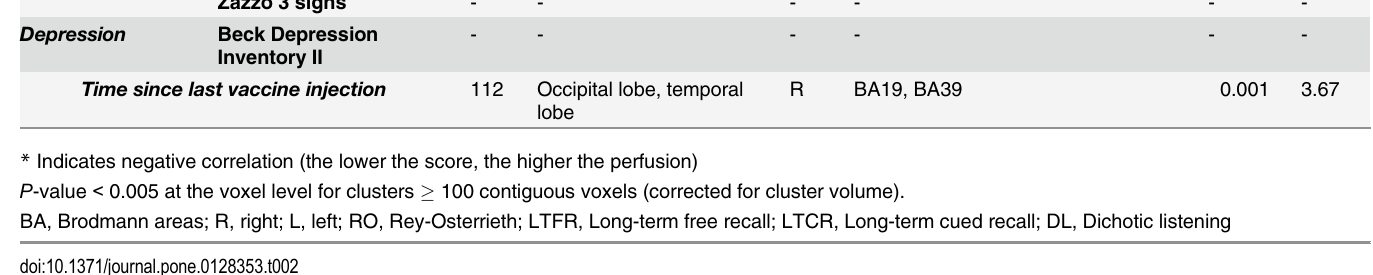
Linear regression analyses emphasized diffuse involvement of periventricular white matter and corpus callosum, proportional to the impairment to left ear dichotic listening tasks. White matter perfusion is generally difficult to assess on an individual level because most of the tracer takes up on the gray matter with a gray-to-white ratio > 2 [15]. However, involvement of peri- ventricular white matter was highly significant with SPM12 analysis in this large population. Although most patients performed well on dichotic listening (mean score for the whole popu- lation = +2.75 words compared with normal), a subset of 12 patients (16%) with callosal